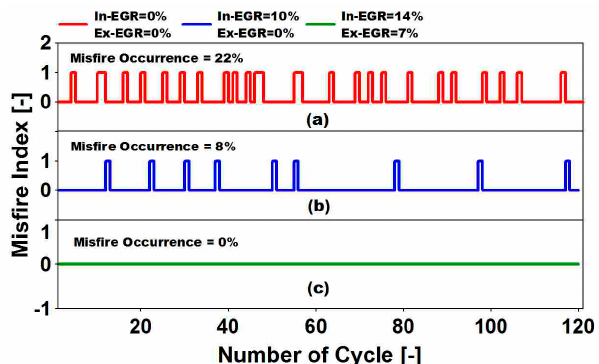
Figure 3. Influence of In-exhaust gas recirculation (EGR) and Ex-EGR on misfire occurrence at Idling condition (rpm = 1000, IMEP = 1 bar, T epc = 420 K, AFR = 15).